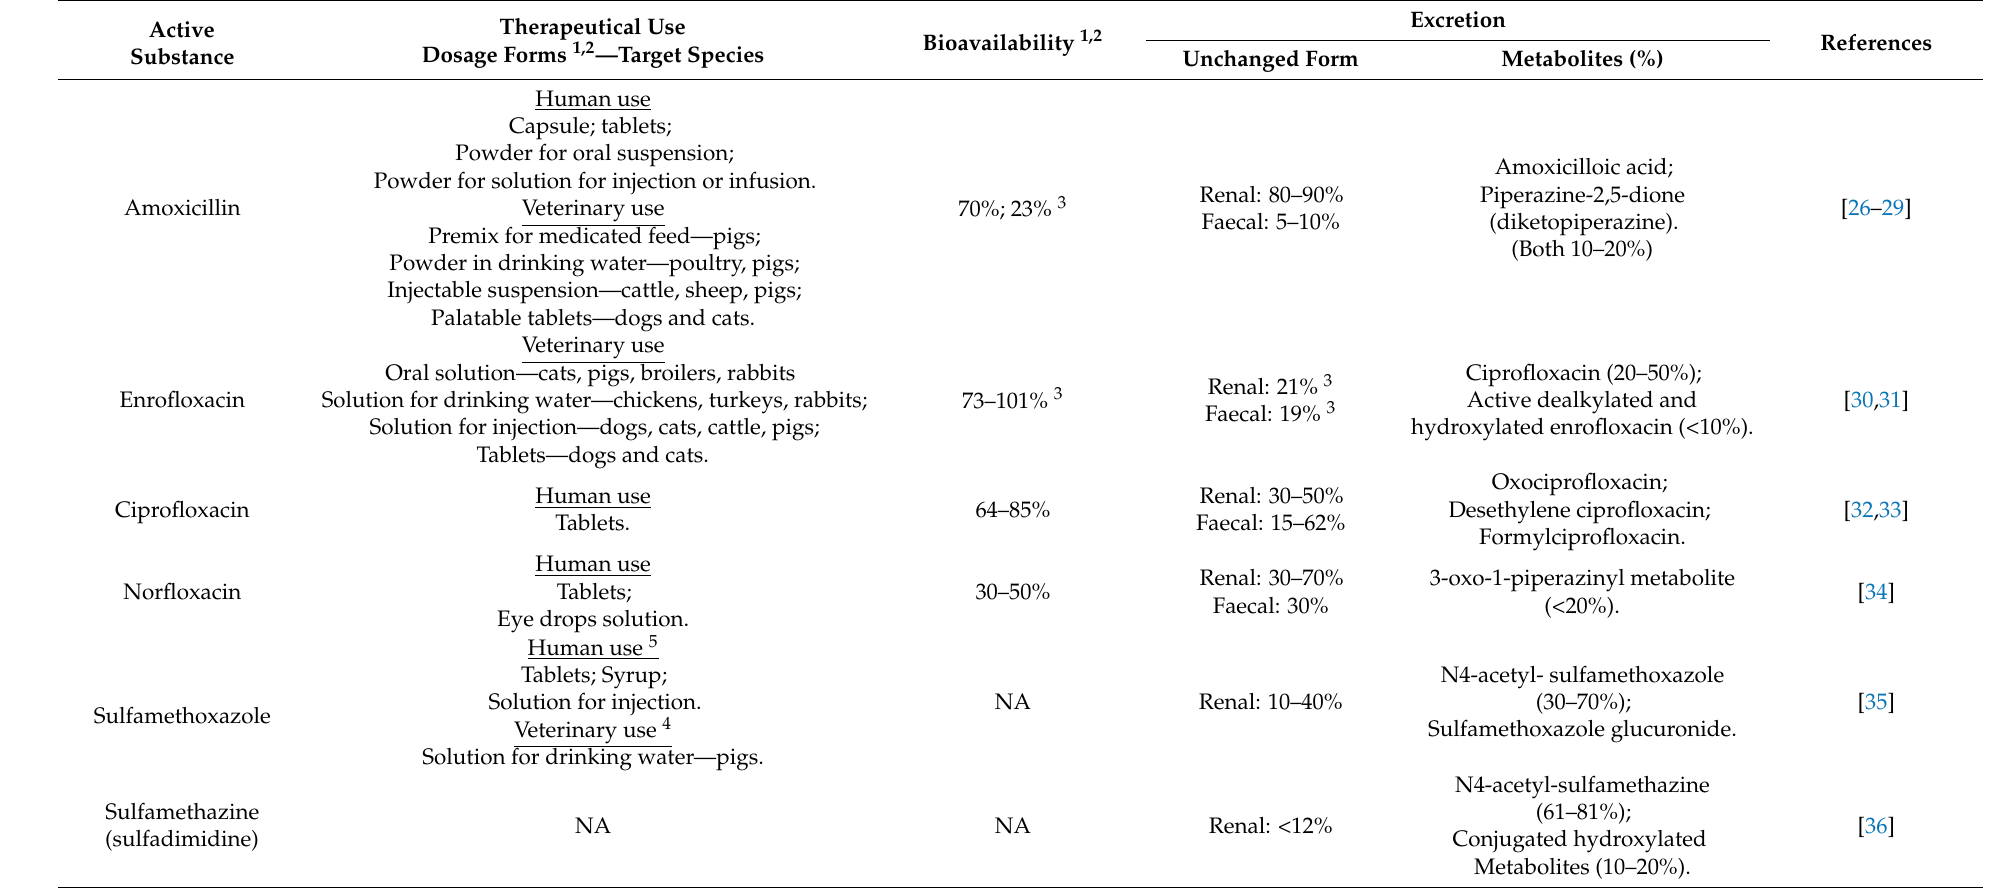
Table 3. Main pharmacokinetic properties of detected